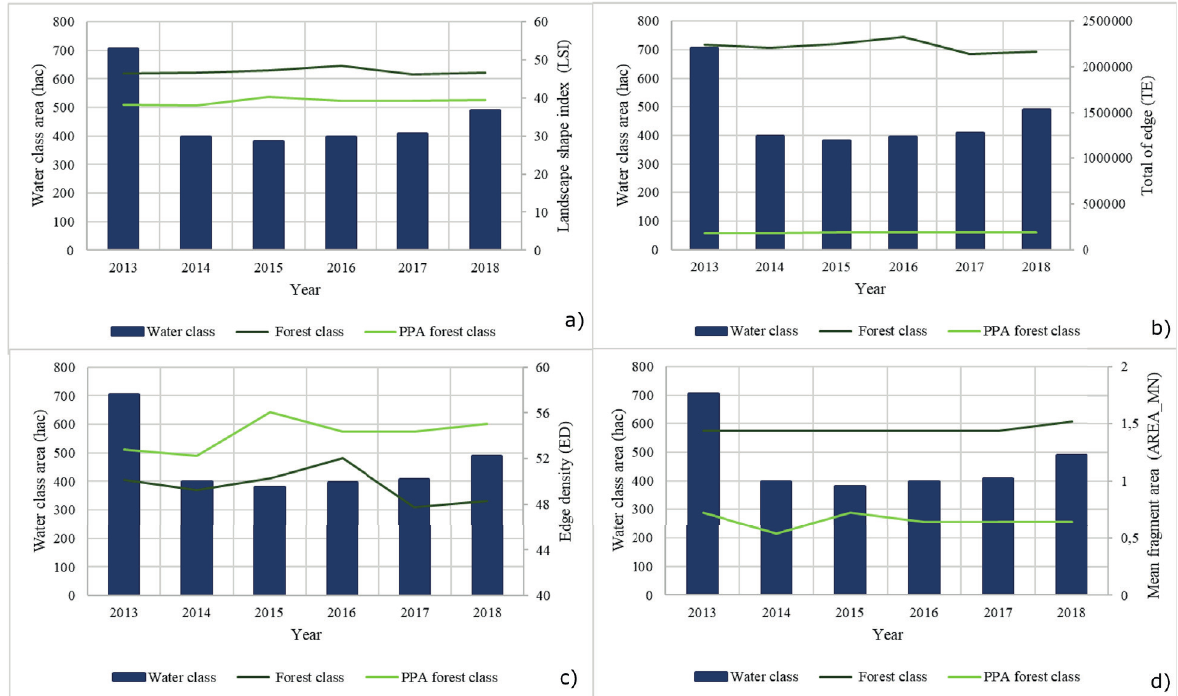
Figure 3. Var iation of form metrics along landscape, where a) landscape shape index - LSI, b) total of edge - TE, c) edge density - ED and d) mean fragment area -